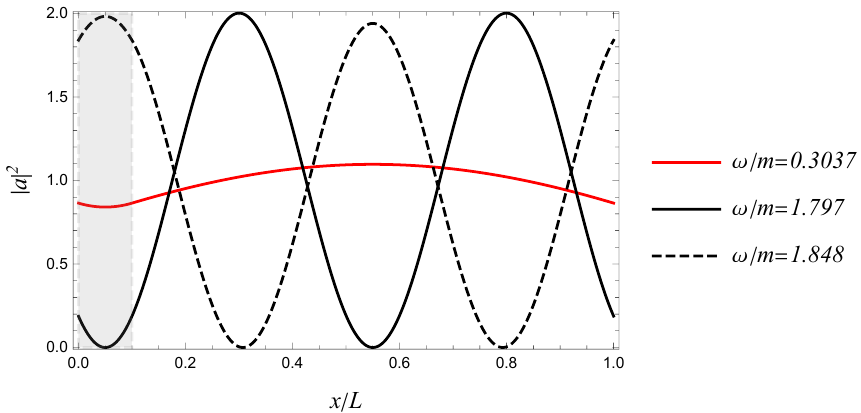
Figure 1 . An illustration. The probability density distribution of eigen-wavefunctions of 1D time- independent Schrödinger equation in a compactified spacetime, x ∼ x + L . The gray region labels the potential barrier, which is chosen l/L = 0 . 1 and mL = 3 . 5 . The red line labels the only state with energy ω < m .